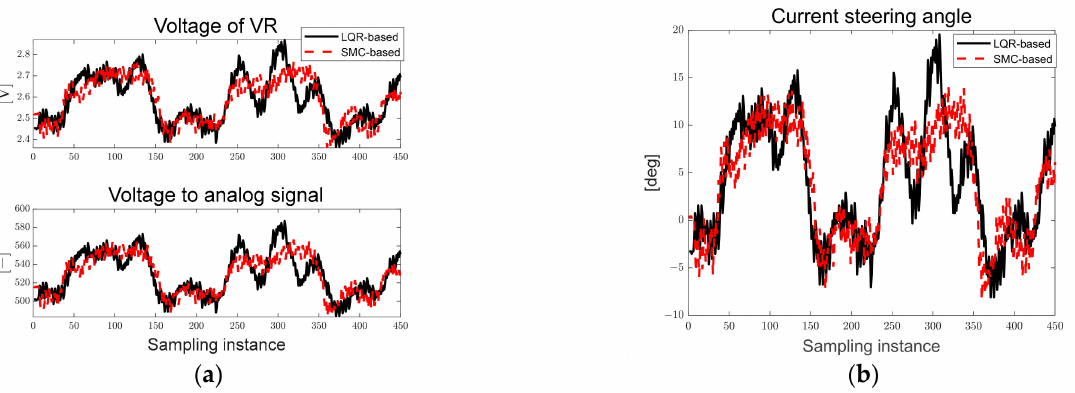
Figure 26. Ellipse path tracking scenario results; ( a ) voltage of VR and analog signal for map-based calculation; ( b ) current steering angle.